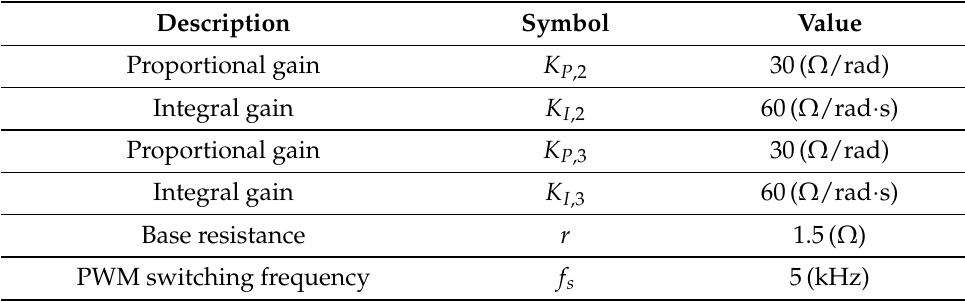
Table A5. Parameters for External Resistor Circuit and